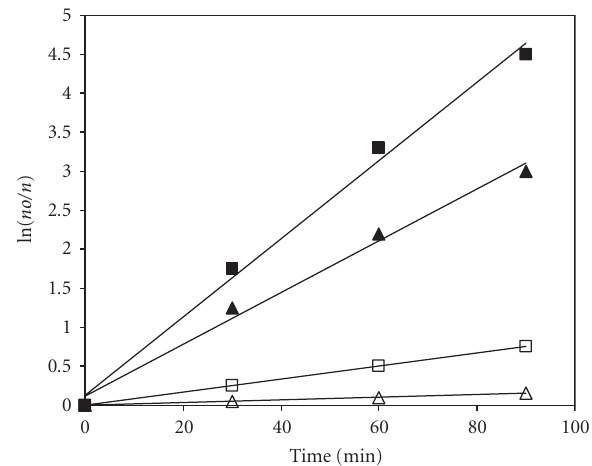
Figure 4: Apparent first-order linear transform ln (n 0 /n) = f(t) of the p-nitrophenol concentration during its degradation; UV-light: ( (cid:2) )—bare TiO 2 , ( (cid:3) )—13% AC-TiO 2 ; solar light: ( (cid:4) )—bare TiO2, ( (cid:5) )—13 % AC-TiO2 .